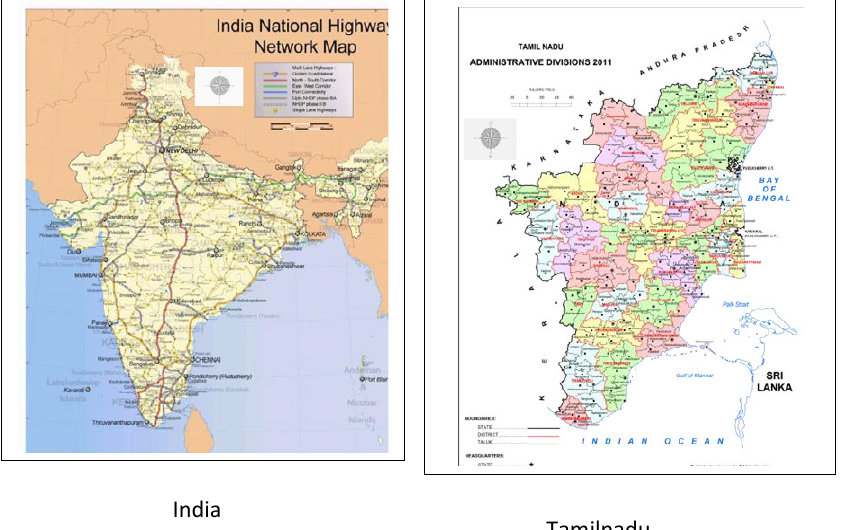
Fig. 2: Study Area Map Showing the location of Air Quality Monitoring